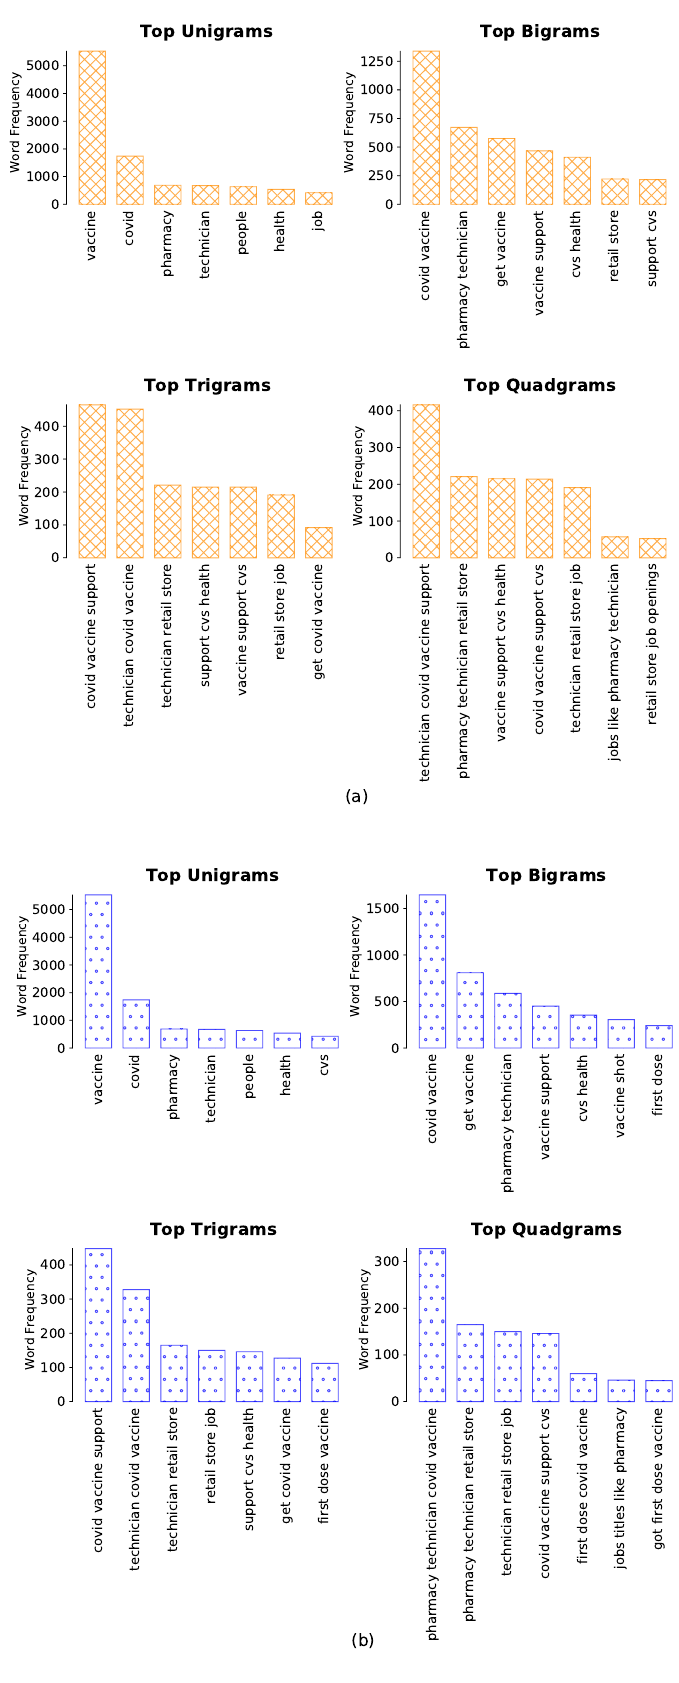
Figure 4. N-grams. ( a ) Tweets posted in early February 2021. ( b ) Tweets posted in late March